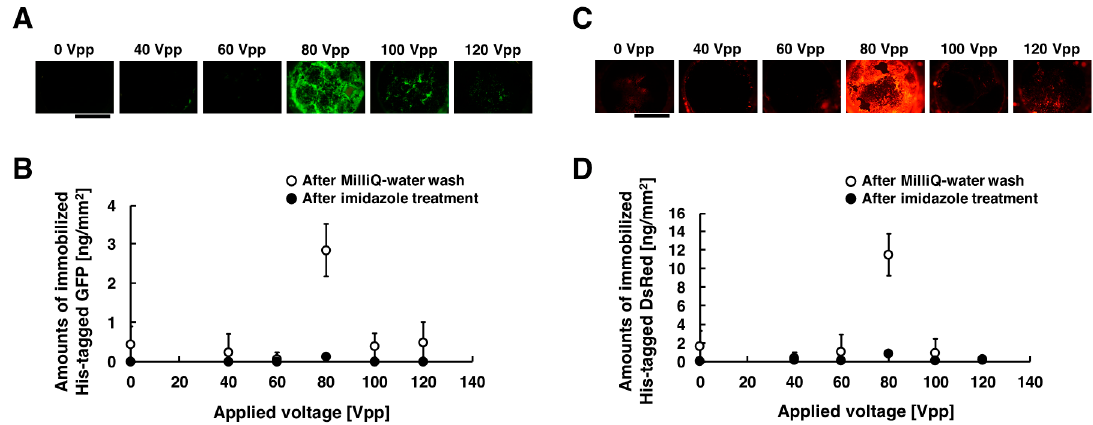
Figure 4. Fluorescent images and amounts of immobilized His-tagged GFP and DsRed by applying AC electric field. The conditions of applying AC electric field are described as follows: 0, 20, 40, 60, 80, 100, and 120 Vpp of 20 Hz for the duration time of 30 min. ( A ) After the application of AC electric field, fluorescence images of immobilized His-tagged GFP. ( B ) After Milli-Q water wash and imidazole treatment, amounts of immobilized His-tagged GFP. ( C ) After the application of AC electric field, fluorescence images of immobilized His-tagged DsRed. ( D ) After Milli-Q water wash and imidazole treatment, amounts of immobilized His-tagged DsRed. Open and closed circle denote the amounts of immobilized His-tagged GFP and DsRed after Milli-Q water wash and imidazole treatment, respectively. Error bars represent the standard deviations from three independent experiments. Scale bar = 1 mm.